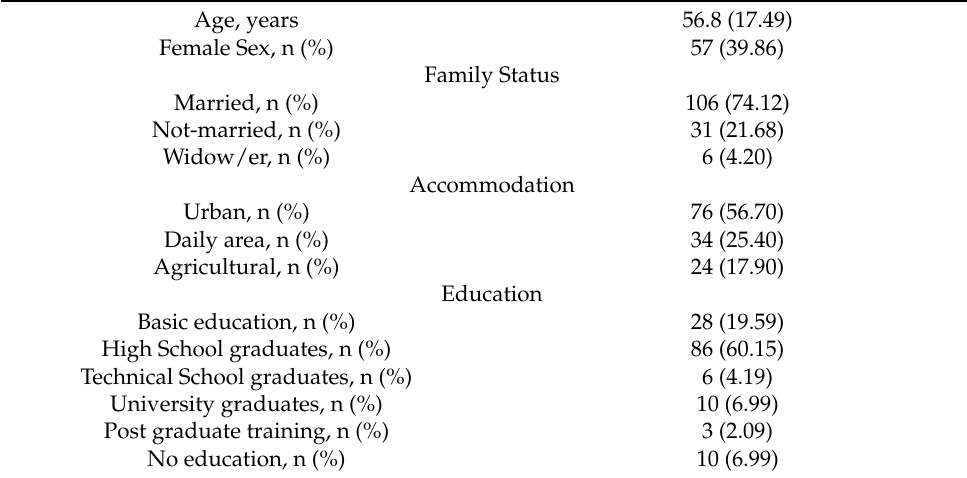
Table 1. Social and demographic characteristics of